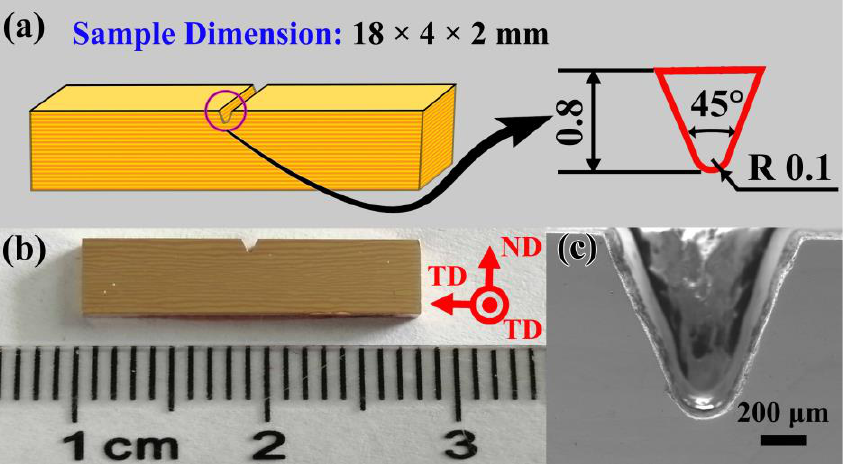
Figure 2. ( a ) The dimensions of the impact specimens in the present work. ( b ) Impact specimens cut from a multilayered soft – hard copper – brass block. ( c ) A scanning electron microscope (SEM) image of the V-notch.